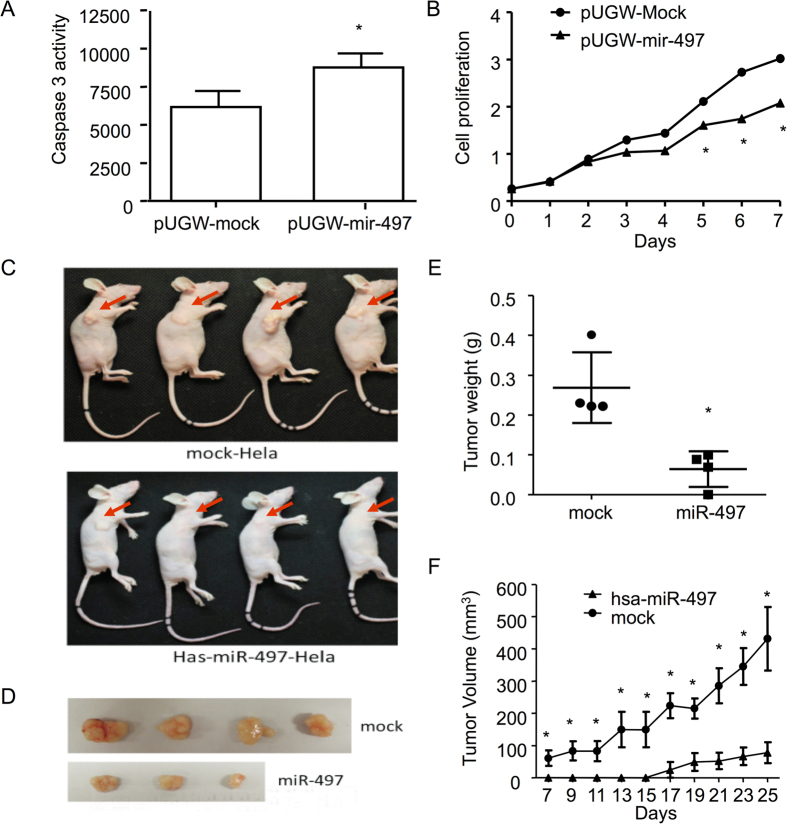
Tumor growth suppression of miR-497 in vitro and in nude mouse model.Stable cell lines over-expressing miR-497 was established and confirmed with flow cytometry while mock-transfected Hela cells served as negative control. Influences of the Hela cells over-expressing miR-497 to apoptosis was analyzed with Caspase 3/7activity (A). Proliferation abilities were determined along a time course with MTT assay (B). After injection of Hela cells or miR-497 over-expressing Hela cells, different size of tumors grew at the site of injection and tumors obtained from the mice were showed (C,D). Weight of the tumors was quantified and volume of the tumors along the time course were compared between mock transfected and miR-497 over-expressing cells (E, F). P values were calculated using the Ttest. ns, p > 0.05 and inferred as not significant; *p < 0.05.